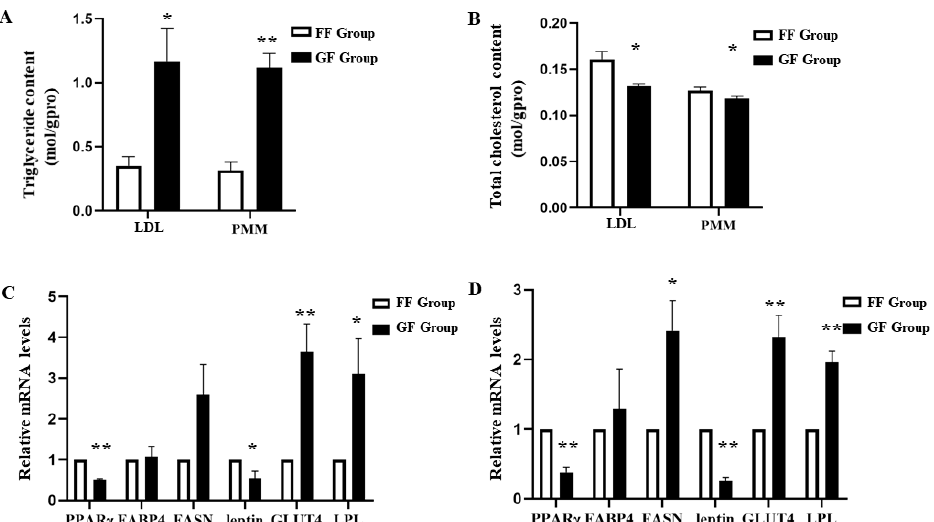
Figure 2. The expression of CRTC3 and adipogenesis related genes in the longissimus thoracis et lumborum (LTL) and psoas major muscle (PMM)of Heigai pigs. ( A ) Triglyceride contents in the LTL and PMM. ( B ) Total cholesterol contents in the LTL and PMM. ( C ) Relative mRNA expression levels of adipogenesis related genes, including PPAR γ , FABP4, FASN, leptin , GLUT4 and LPL in LTL. ( D ) Relative mRNA expression levels of adipogenesis related genes in PMM. Each column represents the means ± SEM ( n = 5). * p < 0.05; ** p <